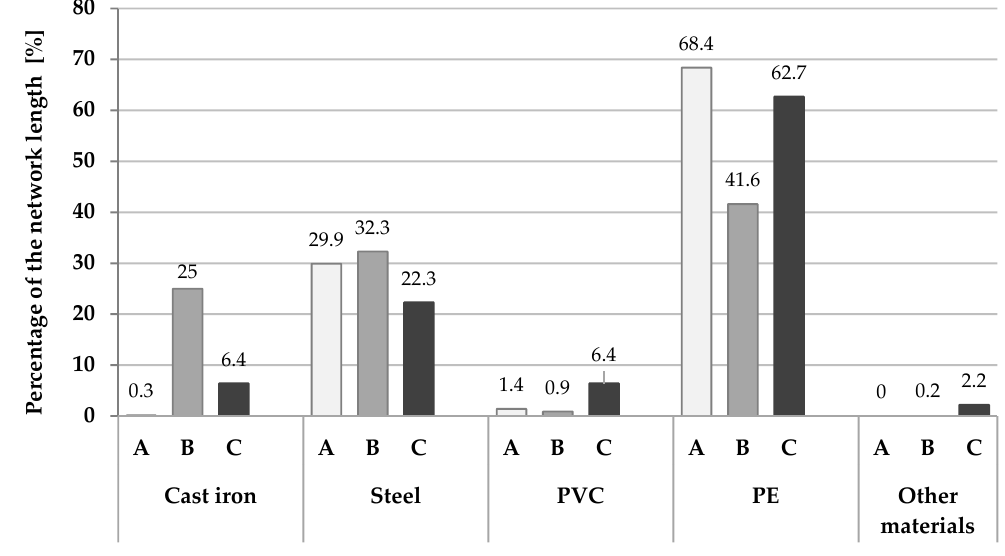
Figure 1. Material structure of water supply networks of companies A, B and C.